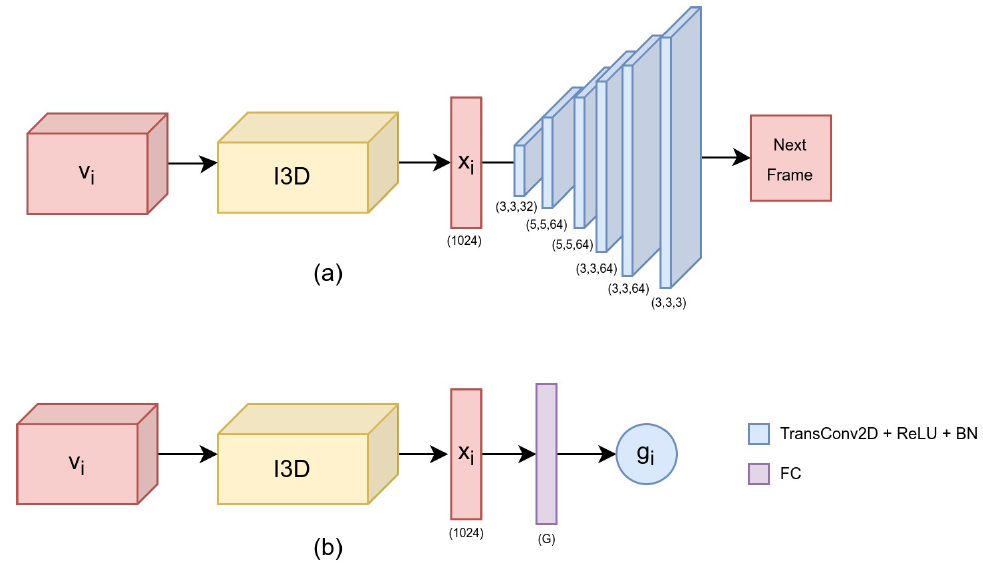
Figure 3. The two ST module architectures employed: ( a ) ST Model 1 and ( b ) ST Model